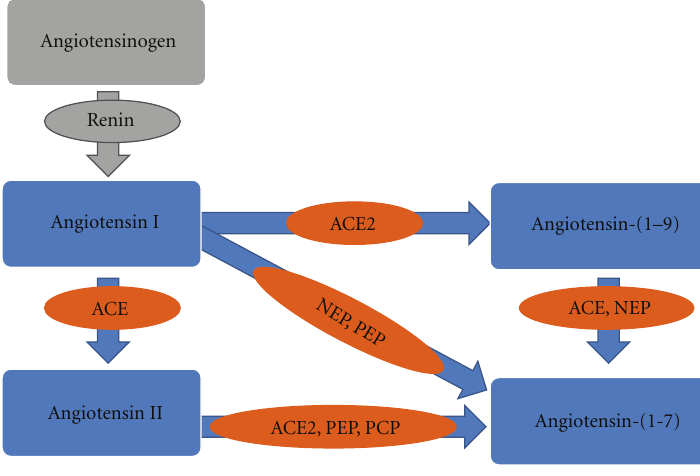
Figure 1: Schematic representation of the enzymatic pathways involved in the generation of Ang-(1-7). Ang-(1-7) can be formed by at least three di ff erent pathways: directly from Ang I by NEP and PEP, by hydrolysis of Ang II by ACE2, PEP, and PCP, and finally by hydrolysis of Ang-(1-9) by ACE and NEP. ACE, ACE2, and NEP are found in cardiomyocytes.